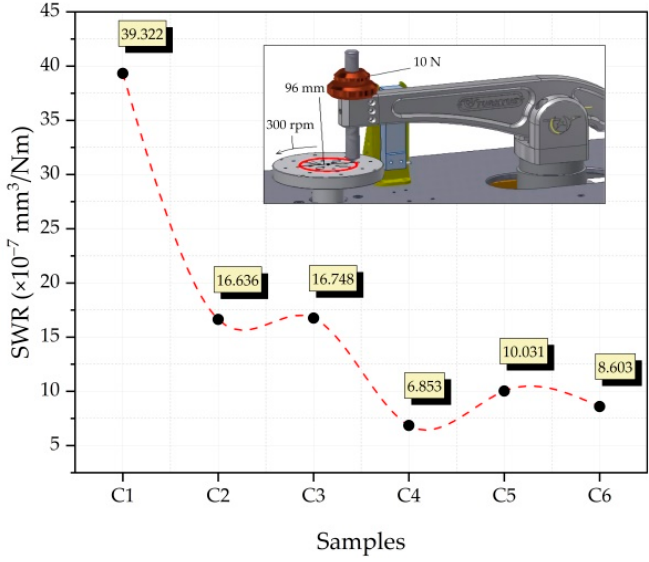
Figure 12. Specific wear rate graph resulting from the wear test.